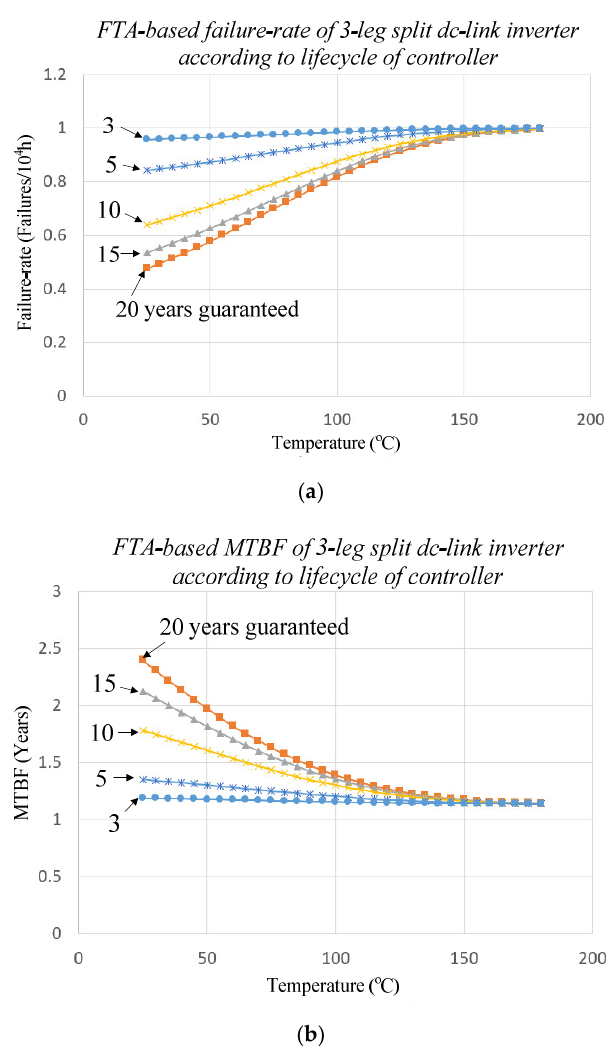
Figure 15. Failure rate and MTBF of split-DC-link capacitor 3-leg inverter according to the controller lifecycle: ( a ) Failure rate; ( b ) mean time between failures, year.